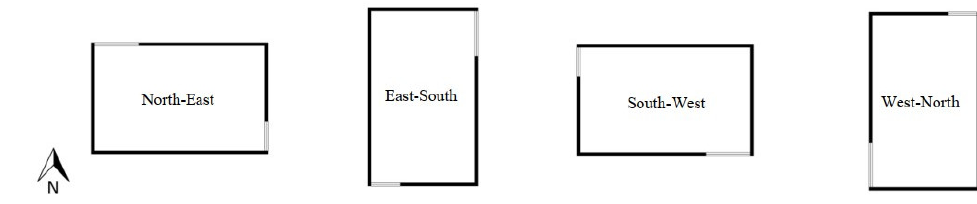
Figure 1. Reference model’s office room model and investigated solar orientations.